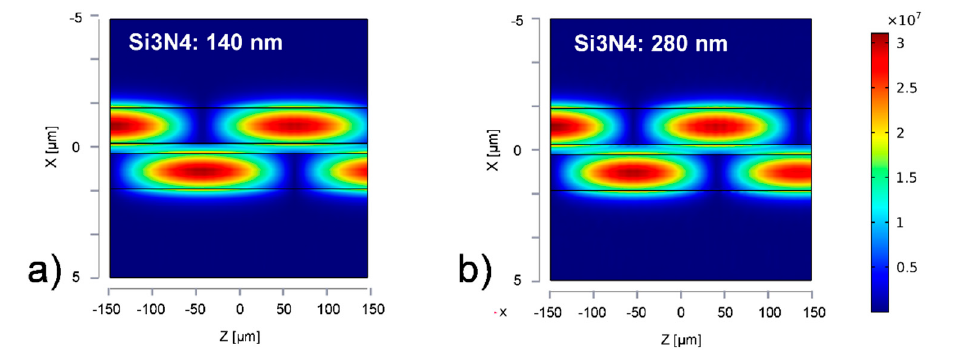
Figure 4. ( a , b ) Representative simulation results for directional coupler structures with a thickness of the Si 3 N 4 layer as indicated in the graph. The wavelength is 4.26 µm. The gap between the waveguides was 400 nm. The amplitude of the electric field is plotted. Optical parameters were taken from the COMSOL data base according to literature.